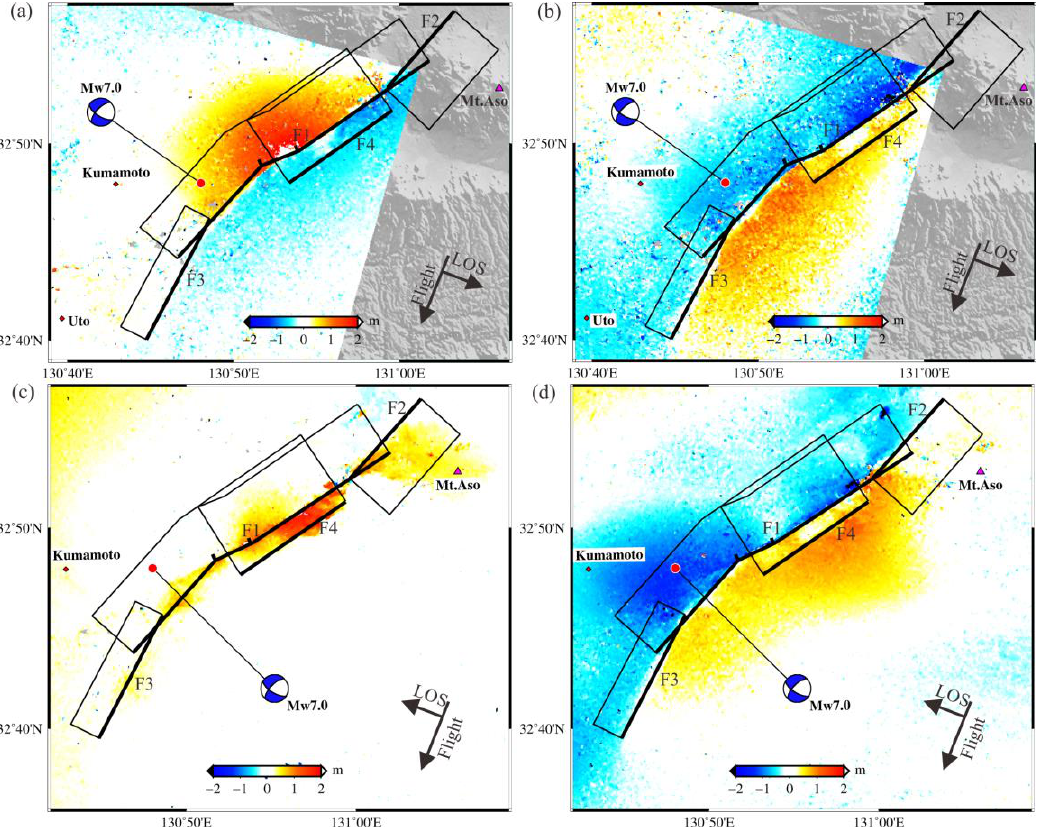
Figure 3. Surface deformation in the azimuth/range directions measured by the PO technique from ALOS-2 images. Ground deformation along the slant-range ( a ) and azimuth ( b ) directions from the DL track. Displacements along the slant-range ( c ) and azimuth ( d ) from DR data. Rectangles indicate the constructed faults projected onto the ground. Bold lines indicate the surface traces of the related faults.